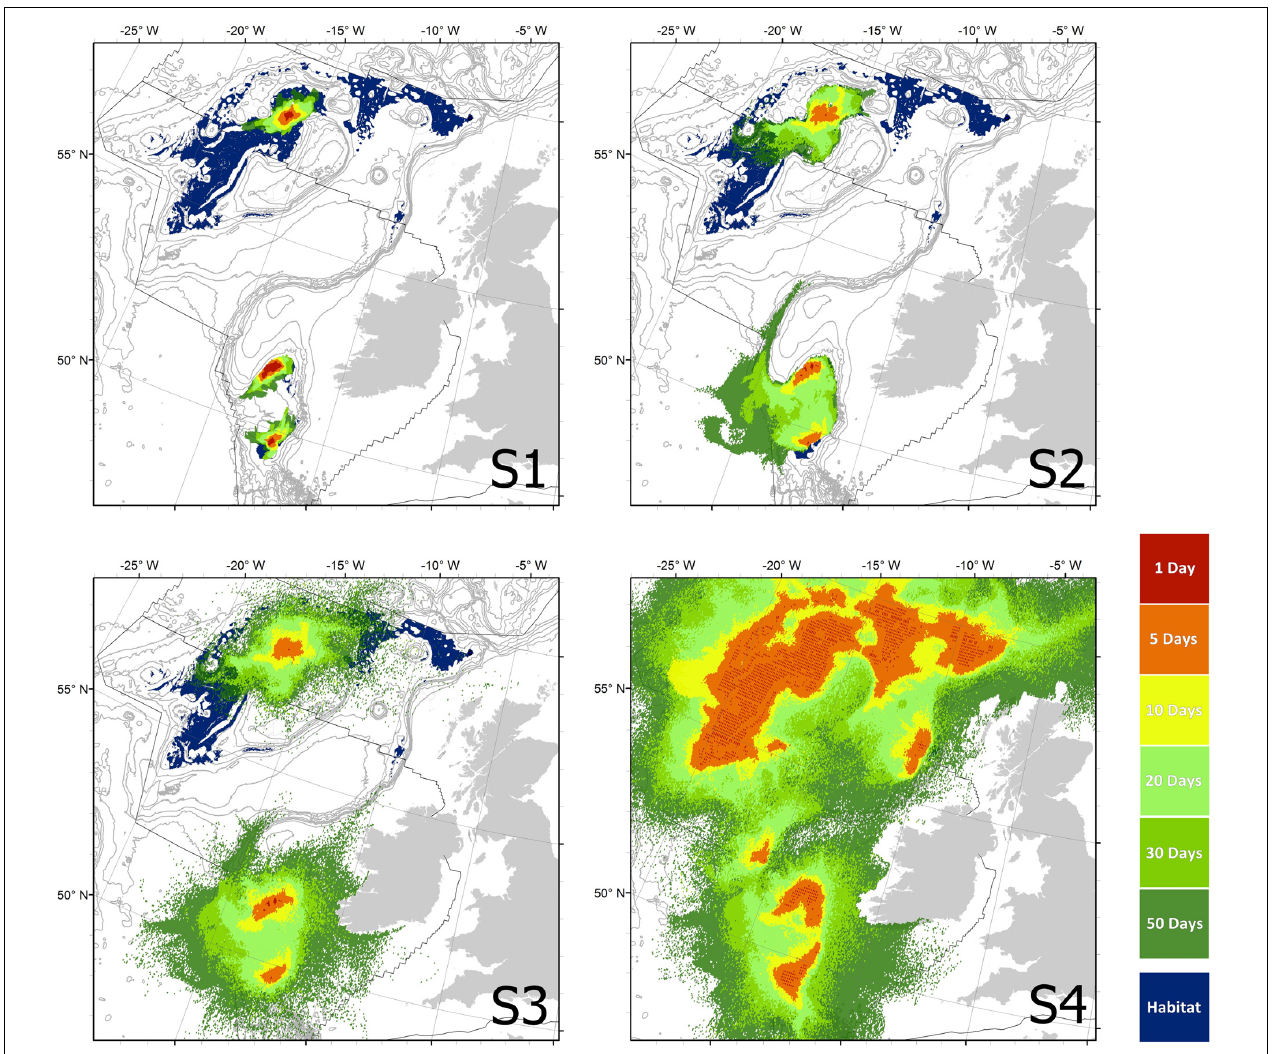
FIGURE 2 | Maps of the four scenarios showing the habitat suitability model (Ross and Howell, 2013) predicted habitat overlaid with the footprints of each of the six Planktonic Larval Durations (PLDs). Background bathymetry contours from GEBCO show every 200–1000 m depth, then every 500 m. Black lines show the current extent of the United Kingdom and Irish continental shelves within the study